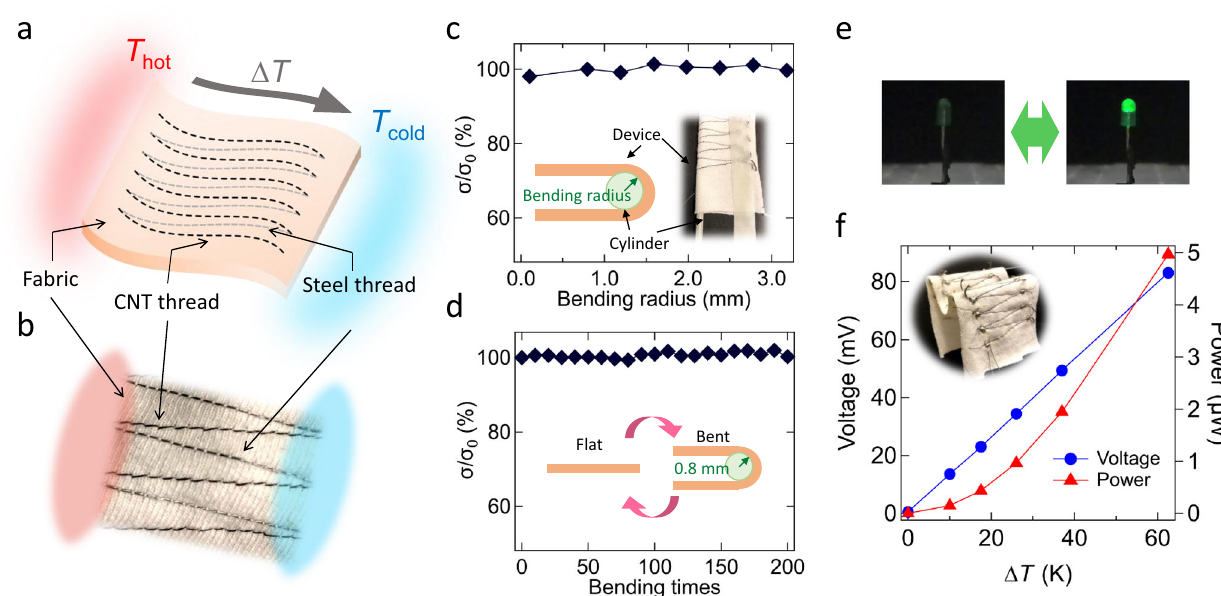
Fig. 3 Textile thermoelectric (TE) generator based on carbon nanotube (CNT) threads sewn into fabric. a Schematic and b photograph of the device. CNT threads (p-type thermoelectric generator) and steel threads (for electrical connection) were sewn into a fabric using a sewing machine. The CNT threads were connected electrically in series and thermally in parallel. A temperature difference Δ T was applied by heating one side ( T hot ) while keeping the other side ( T cold ) at room temperature. c Electrical conductivity σ of one TEG unit as a function of bending radius, normalized by the conductivity without bending ( σ 0 ). The inset shows a schematic and a picture of the device during the measurement. d σ as a function of bending number, normalized by that of the original state ( σ 0 ). The bending radius was 0.8 mm. The inset shows a schematic of the measurement procedure. e The entire device was connected to an LED through an ampli fi cation circuit and a capacitor. The LED turned on with a Δ T of ~50 K. f Output voltage and power as a function of applied Δ T . The inset shows a folded device, demonstrating its fl Figure 2g plots the calculated S tot (experimental S ) as a function of calculated G tot (experimental σ ) for direct comparison of our calculations with the gate-dependent data. The overall behavior ( S increases, decreases, and then increases again with σ ) is well reproduced, validating our model.